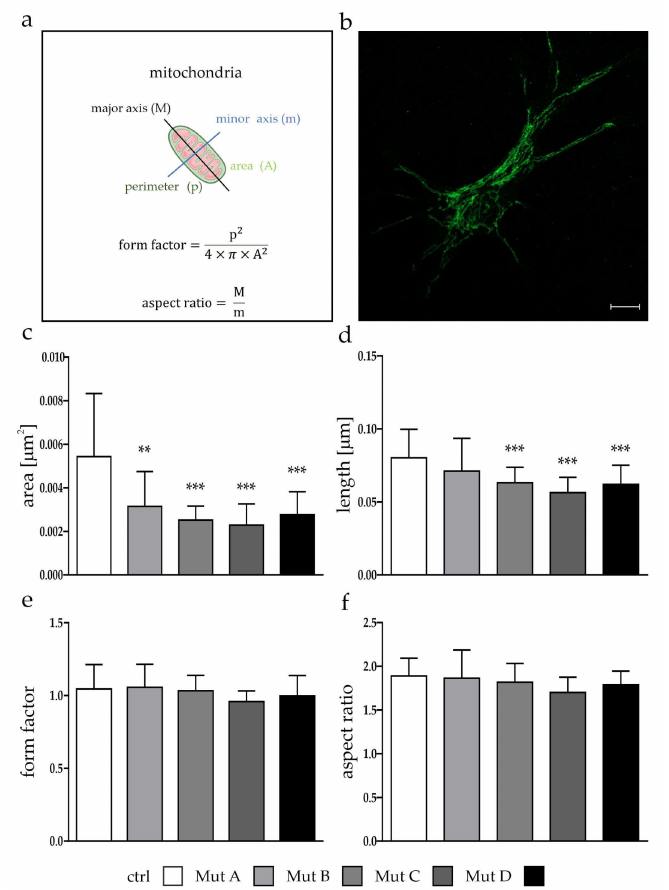
Figure 1. Analysis of mitochondrial morphology. Length (major axis), area, form factor, and aspect ratio of 30 mitochondria from 3 independent experiments were analyzed using immunofluorescence stainings of Tom20. ( a ) Schematic description of the used parameters. Graphic was created with Microsoft PowerPoint. For the graphical representation of the mitochondrion, a template from Smart (Servier Medical Art) [23] was used. ( b ) Example of a Tom20 staining that was used to evaluate mitochondrial size and shape. Scalebar = 10 µ m. ( c ) Mitochondrial area was reduced in all NPC- deficient cell lines. ( d ) The length of mitochondria were reduced, whereas one cell line failed to meet statistical significance. No differences could be observed regarding the calculated ( e ) form factor and ( f ) aspect ratio of mitochondria. Graphs show mean ± SD with N = 3, n = 30. One-way ANOVA and a Kruskal–Wallis post hoc test were used to determine statistical significance, with ** = p < 0.01, *** = p < 0.001. ctrl = control cell line. Mut A (NP-C1): c.1180T>C; Mut B